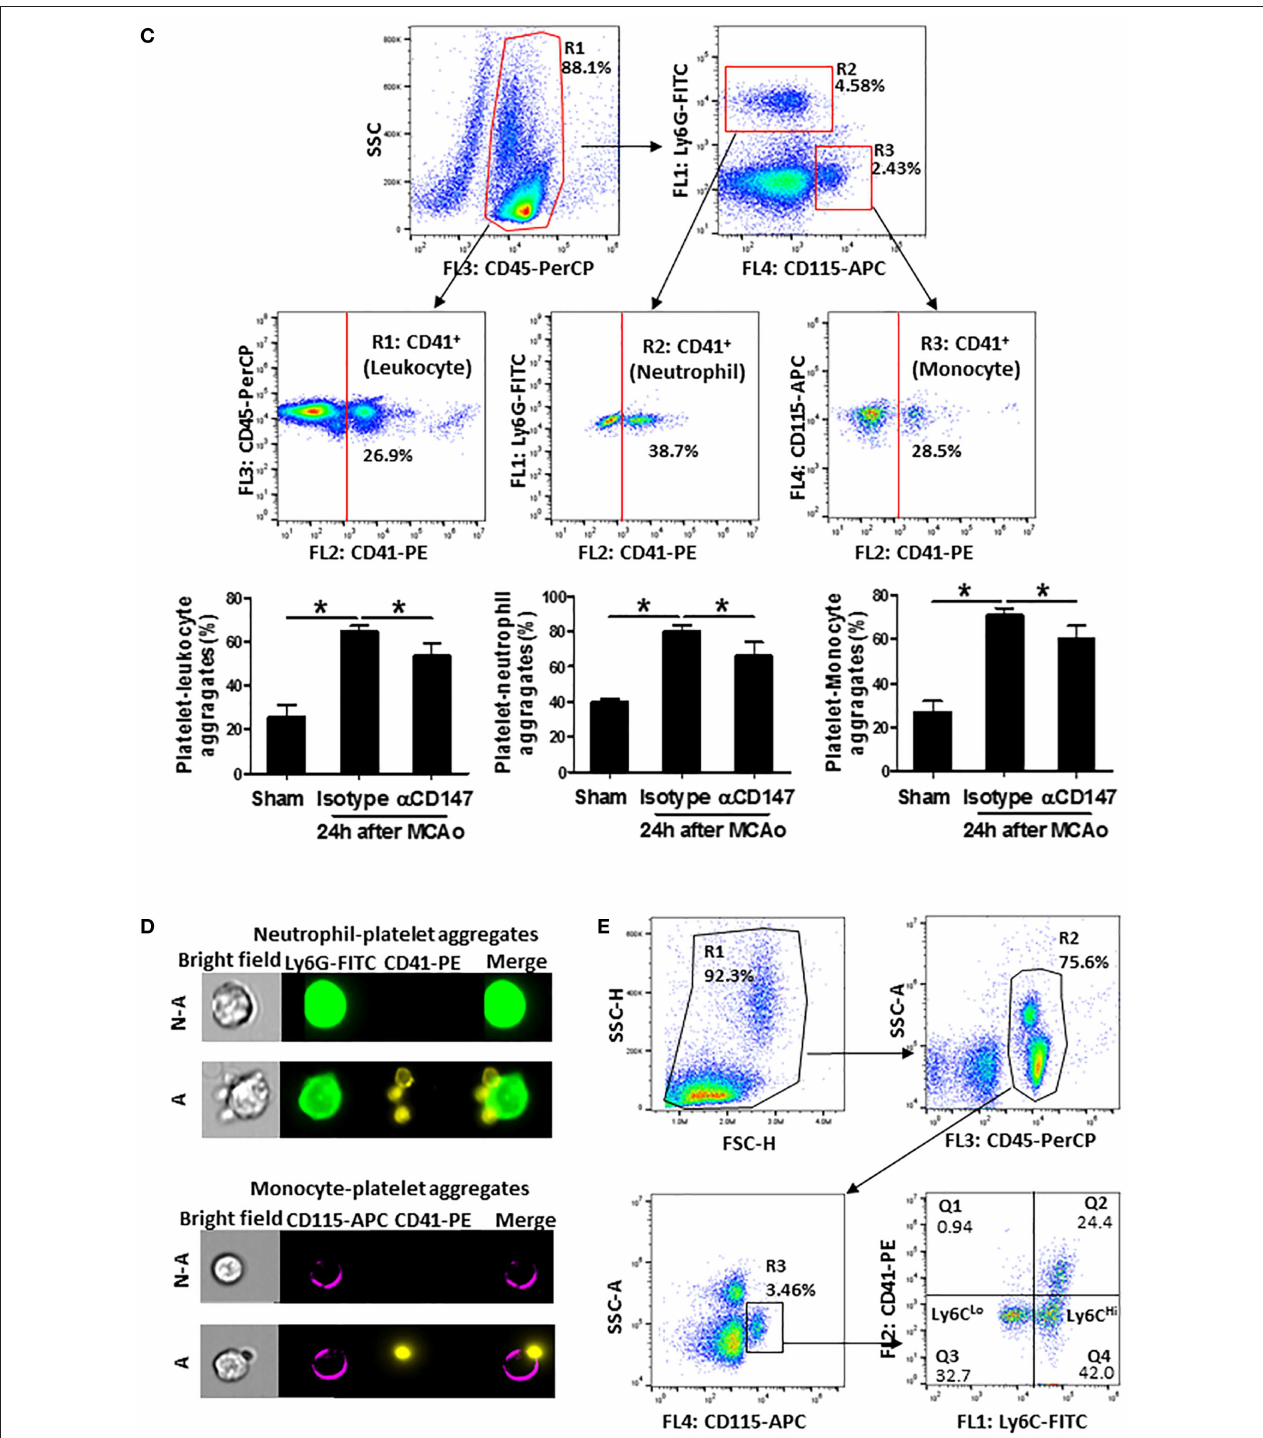
FIGURE 4 | Inhibition of CD147 decreases circulating platelet-leukocyte aggregates after stroke. (A) Representative flow cytometry strategy for gating platelet population (R1, left), which was confirmed by > 98% CD41 positive staining (insert histogram). Histogram of flow cytometry showing CD147 expression on the platelets in the indicated groups (mid) and quantitative analysis of platelets CD147 expression (right). Data are expressed as mean fluorescence intensity (MFI). n = 4 per group. (B) Representative flow cytometry strategy for gating leukocyte population (R1: CD45 + , left), histogram of flow cytometry showing CD147 expression on the leukocytes in the indicated groups (mid) and quantitative analysis of leukocytes CD147 expression (right). n = 4 per group. (C) Representative flow cytometry